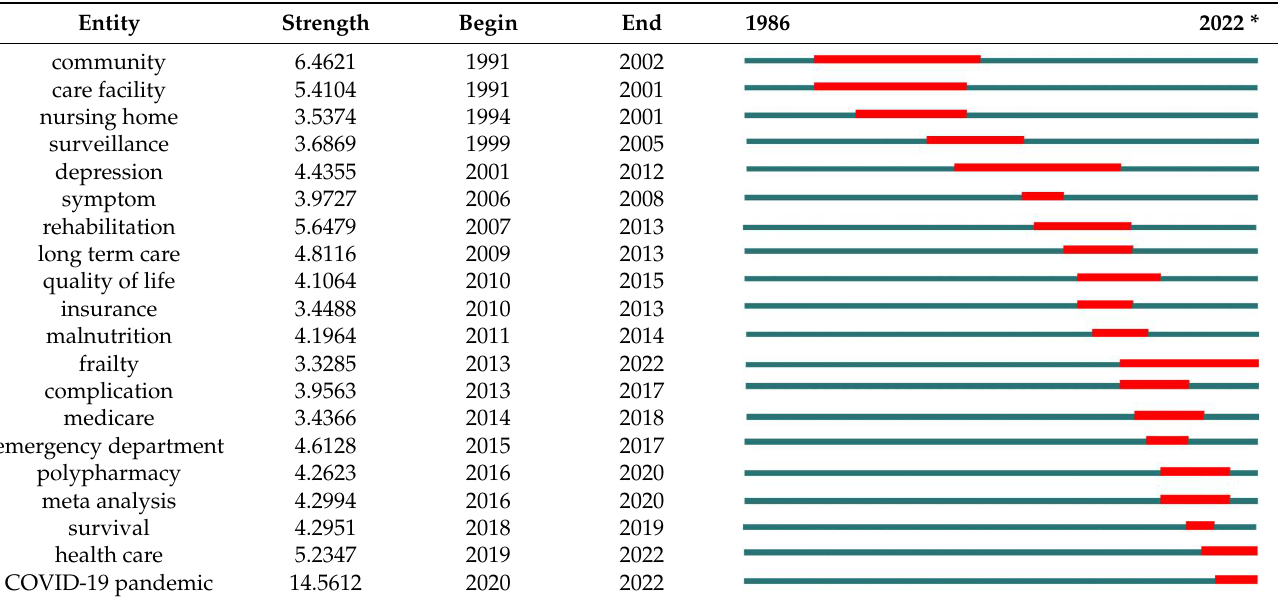
Table 5. Top 20 burst keywords for FCMNCE research, 1986–2022.